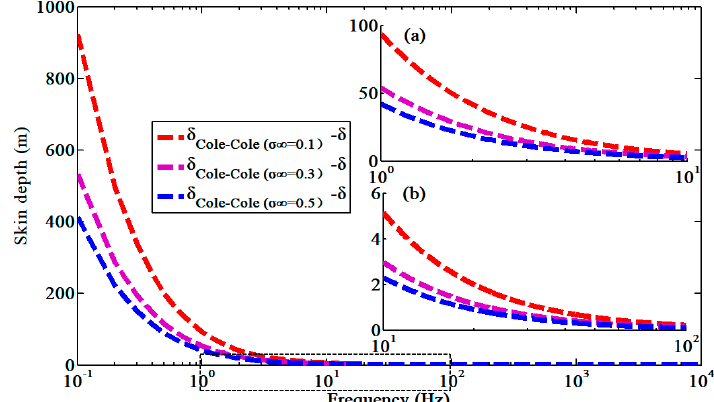
Figure 2. Generalized skin depth of polarized media at different conductivities (red, purple, and blue represent the σ ∞ = 0.1 S/m, σ ∞ = 0.3 S/m, and σ ∞ = 0.5 S/m generalized skin depths of the polarized media, respectively, and the black curve represents the classical skin depth).